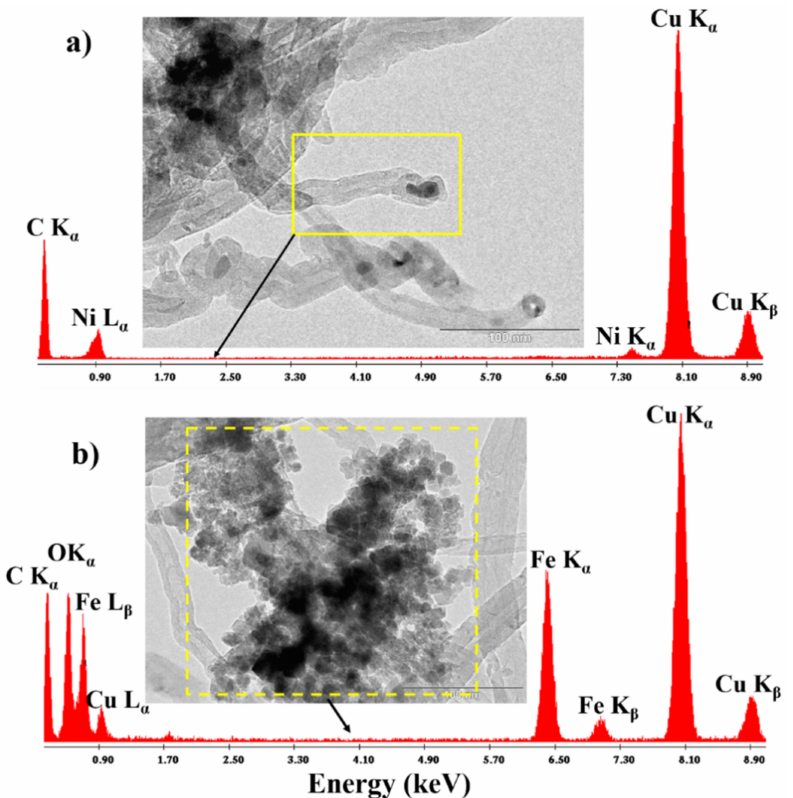
Figure 1. Energy dispersive X-ray analysis-transmission electron microscopy (EDX-TEM) images of the ( a ) multiwall carbon nanotubes (MWCNTs) and ( b ) magnetic NPs functionalized in the MWCNTs (NPMWCNTs). Bar length of 100 nm for both TEM